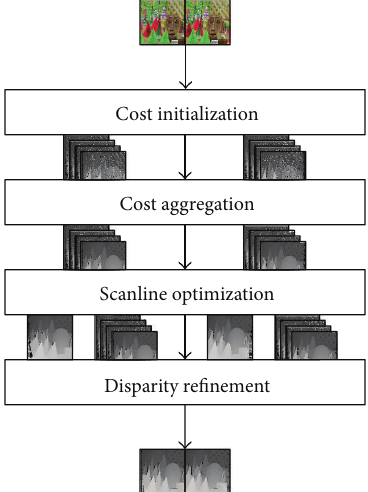
Figure 1: High-level overview of the stereo matching algorithm following [10]. From a pair of stereo images, intermediate cost volumes are computed, which are used to generate disparity maps as final